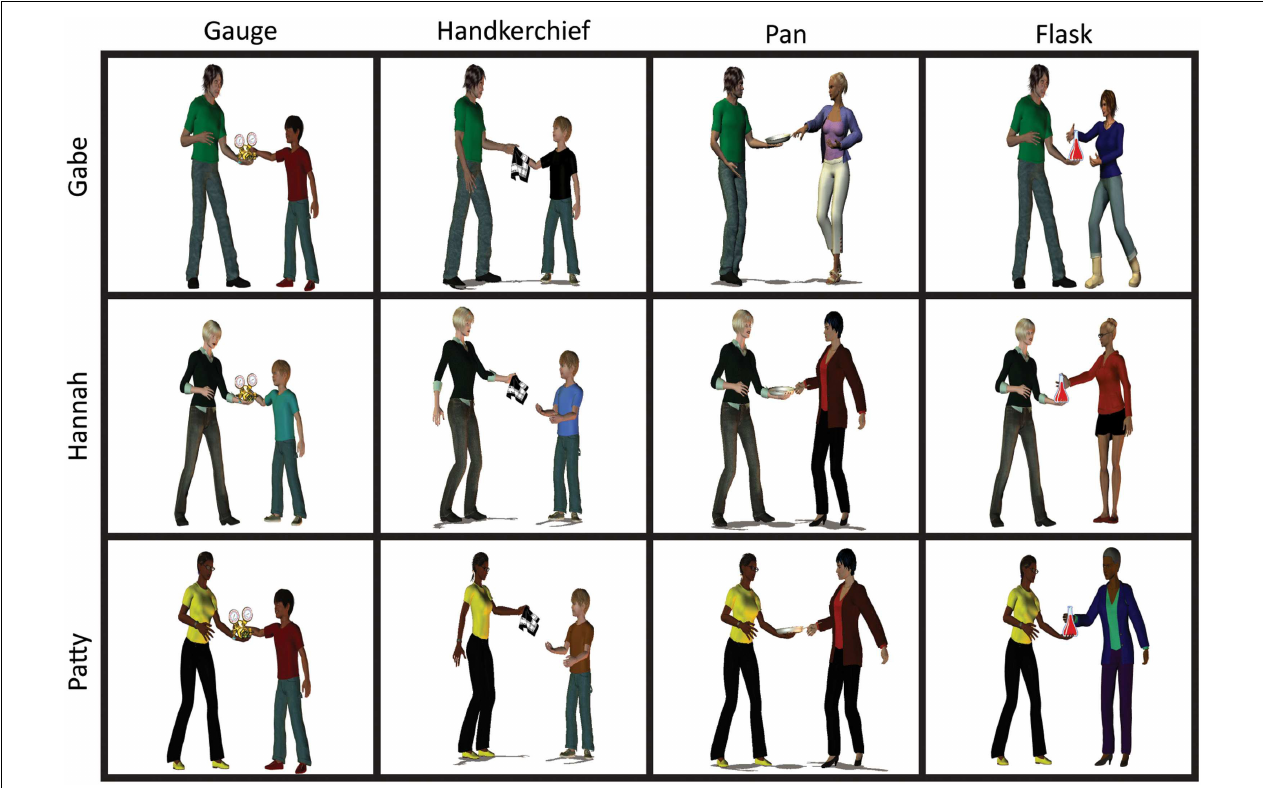
FIGURE 1 | Illustration of design. Reprinted with permission from Jaeger et al.